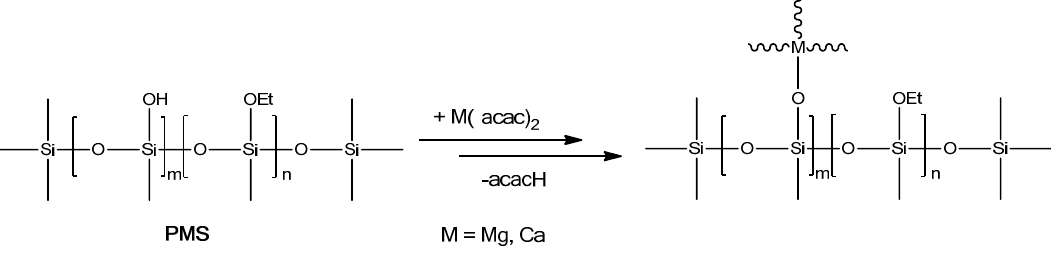
Figure 1. Sketch of the synthesis of the single-source precursor for SiCaMgOC upon chemical modification of PMS with acetyl acetonates of Ca and Mg.